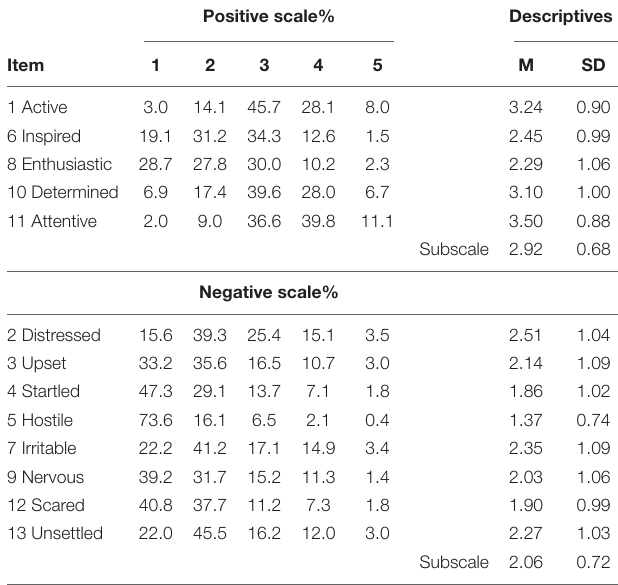
TABLE 2 | Itemized response percentages for the PANAS scale, grouped by